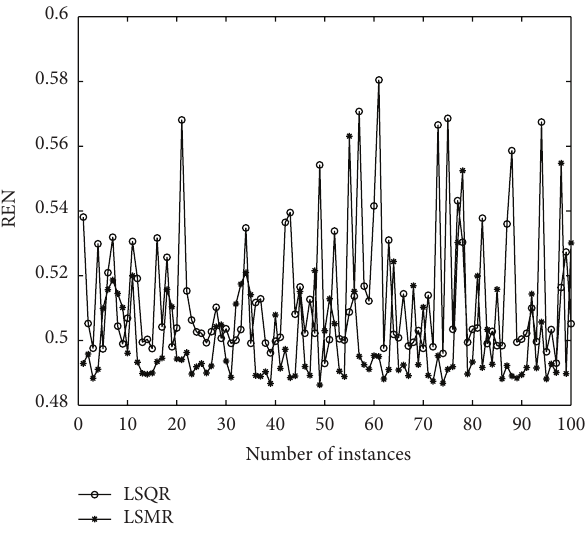
Figure 2: Comparison of the REN produced by LSQR and